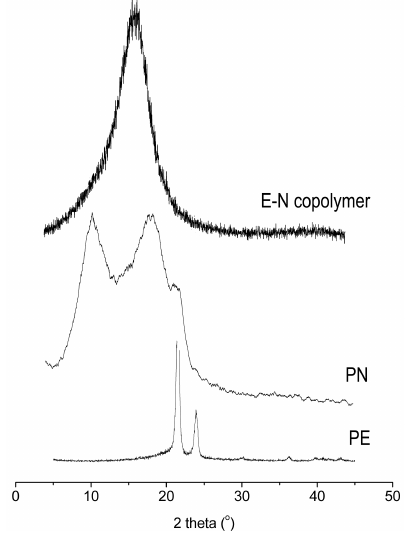
Figure 6. WAXD curves of polymers.